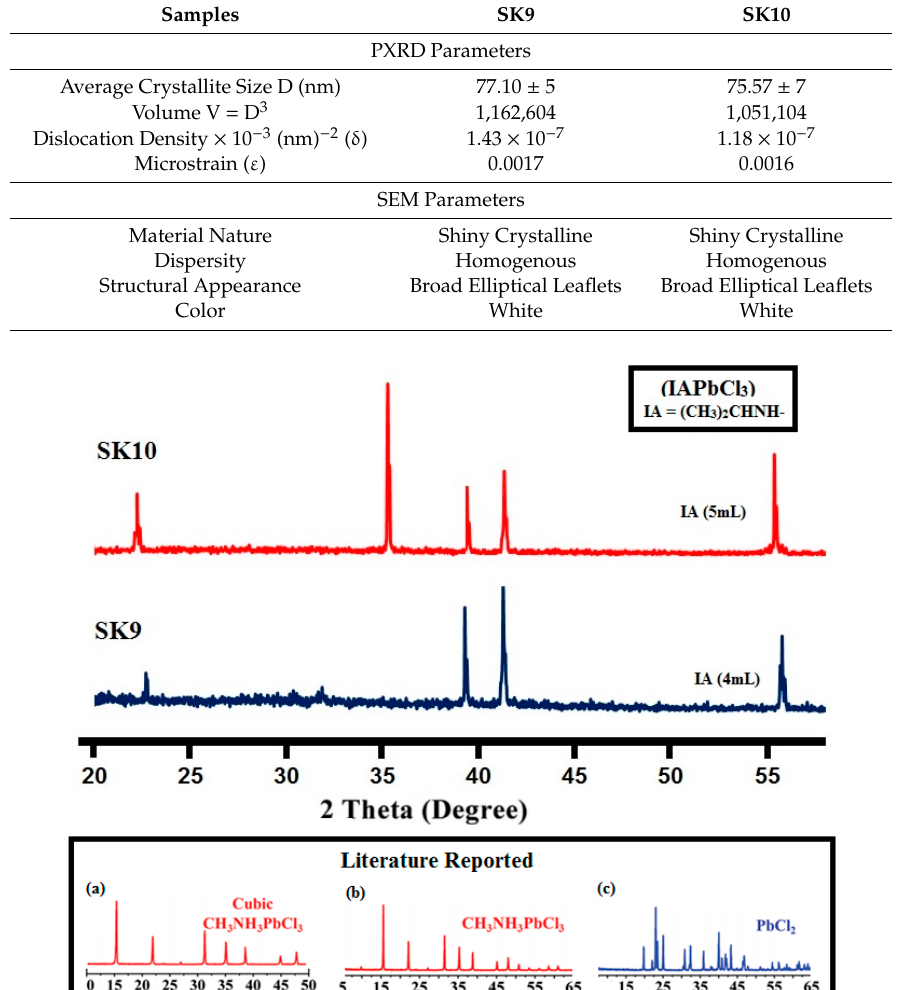
Table 1. PXRD and SEM parameters of perovskite nanomaterials ( SK9 and SK10 ). Samples SK9 SK10